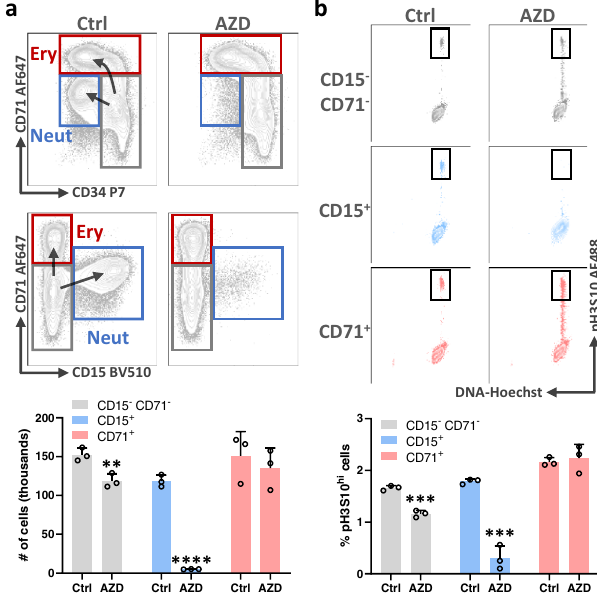
Fig. 2 | Neutrophil sensitivity to AZD2811 is acquired early in hematopoietic differentiation. Human CD34 + progenitor cells were cultured for 4 days and then treated for 48h with AZD2811 at the clinically relevant concentration of 42nM or left untreated. a Cells were harvested and analyzed by fl ow cytometry to measure numbers of early erythroid (CD71 bright CD15 - ; red), early neutrophil (CD15 + CD34 - ; blue),andremainingCD15 - CD71 - CD34 + progenitorcells(gray).Representative fl ow plots showing the various populations are shown along with quantitative bar graphs. Mean and SD are shown; n =3, data are from pooled replicates due to low numbers at early timepoint, from 2 independent experiments. ** p =0.009, **** p <0.0001, two-sided t test. b pH3S10 was measured by intracellular staining and fl owcytometryinthe3differentcellpopulations.Representative fl owplotsare shown along with bar graphs quantitating the percentage of pH3S10 bright cells (gated as shown). Mean and SD are shown; n =3, data are from pooled replicates due to low numbers at early timepoint, from 2 independent experiments. *** p =0.0004 for both indicated comparisons, two-sided t test. Source data are provided in the Source Data fi